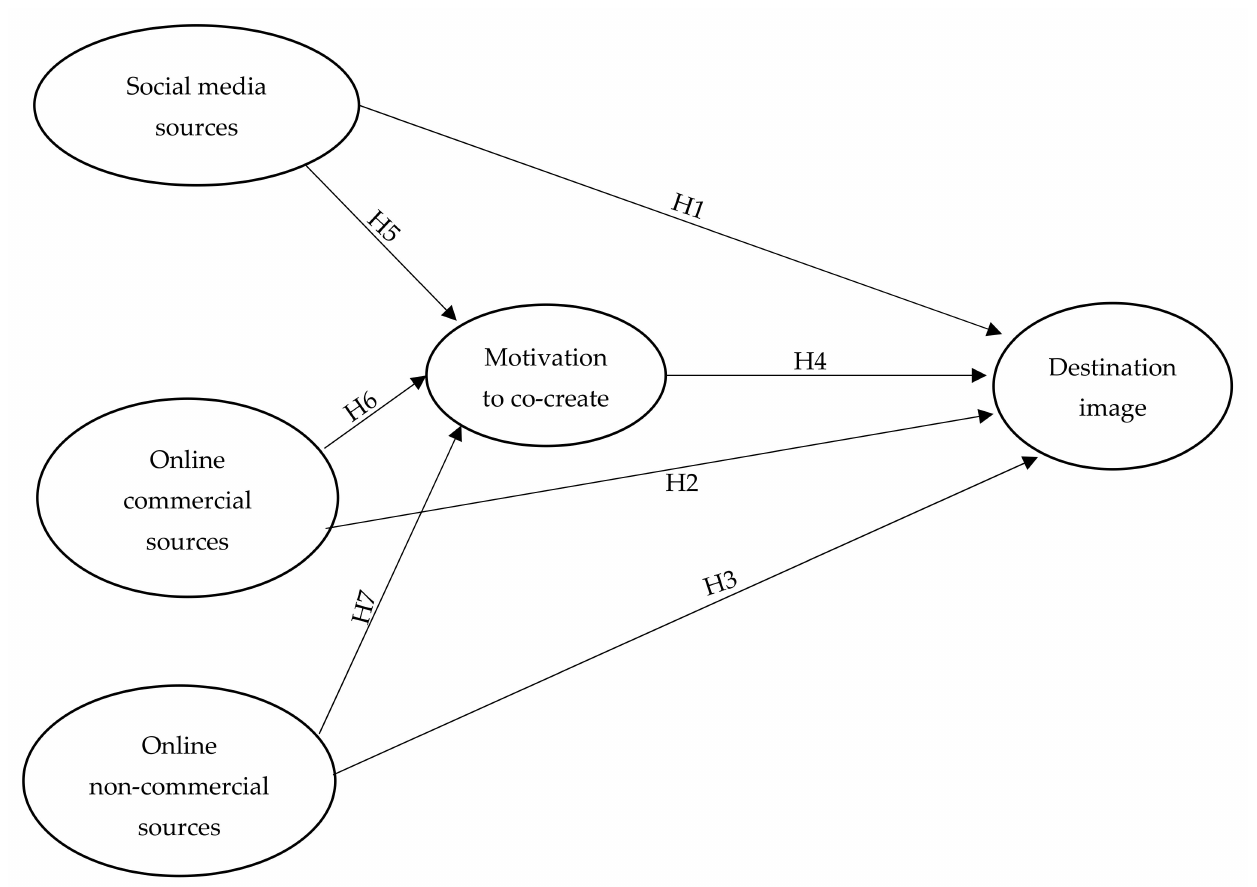
Figure 1. Proposed research